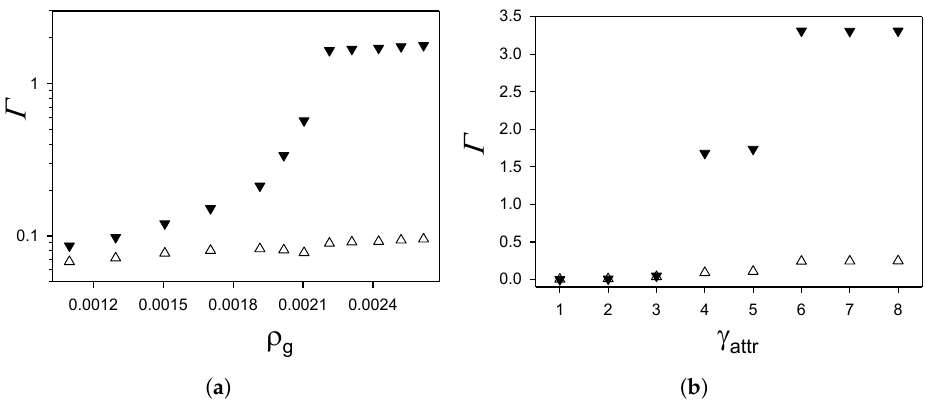
Figure 5. The adsorption Γ (filled symbols) and the selective adsorption Γ c (open symbols) (5) and (6), respectively, in units of 1/ a 2 , where a is the particle diameter, as functions of dimensionless gas density ρ g for γ attr = 4 and γ rep = 16 ( a ) and as functions of the strength of the attractive interactions between the substrate and the first component γ attr for γ rep = 16 and ρ g = 0.0023 ( b ). ¯ T = 0.25 in both panels. Simulations were performed for the initial number of particles N 0 = 6050. The change of Γ for 0.0021 < ρ g < 0.0022 is associated with a significant change of the near-surface structure. In Figure 6, the densities are shown for ρ g = 0.0021 and γ att = 4, γ rep = 16. As can be seen by comparing Figure 6 with Figure 2a, the structure near the same substrate changes significantly when the gas density changes from ρ g = 0.0021 to ρ g = 0.0023. Two layers of the first component for ρ g = 0.0021 are replaced by four layers for ρ g = 0.0022.